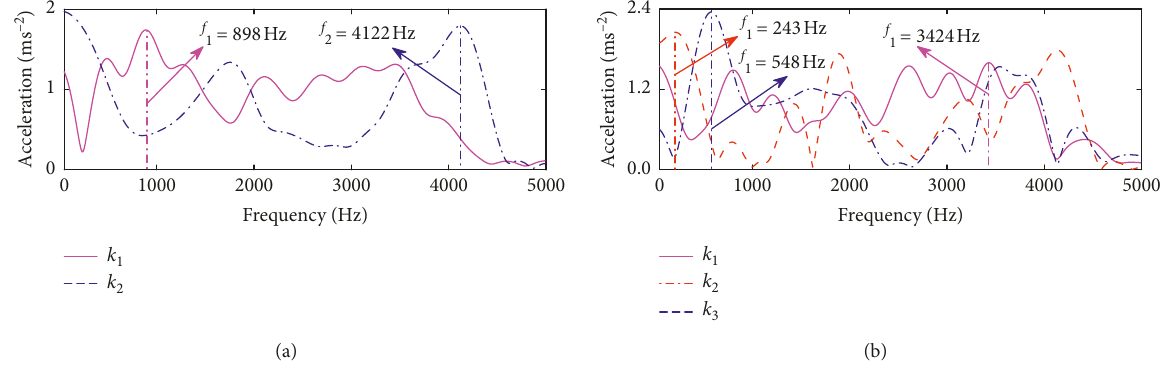
Figure 25: Main frequencies for estimating the impulse response types.